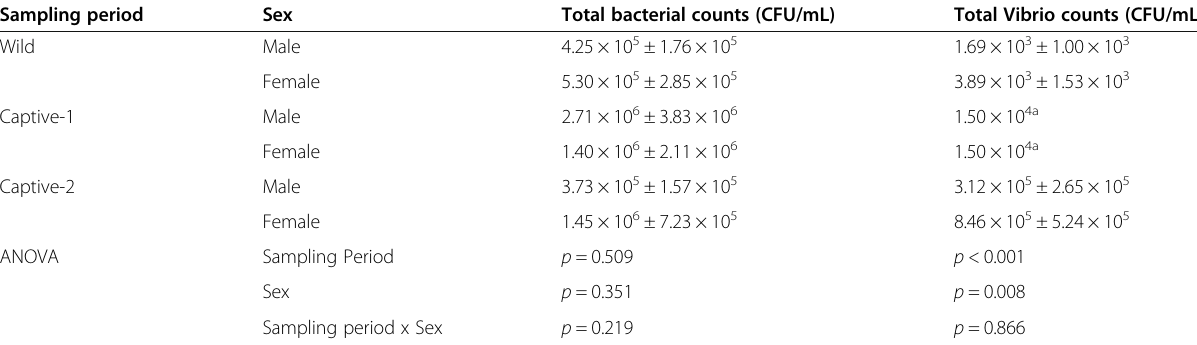
Table 2 Bacterial counts measured from adult common snook external mucus. P values resulting from two-way ANOVA are indicated at the bottom of the table